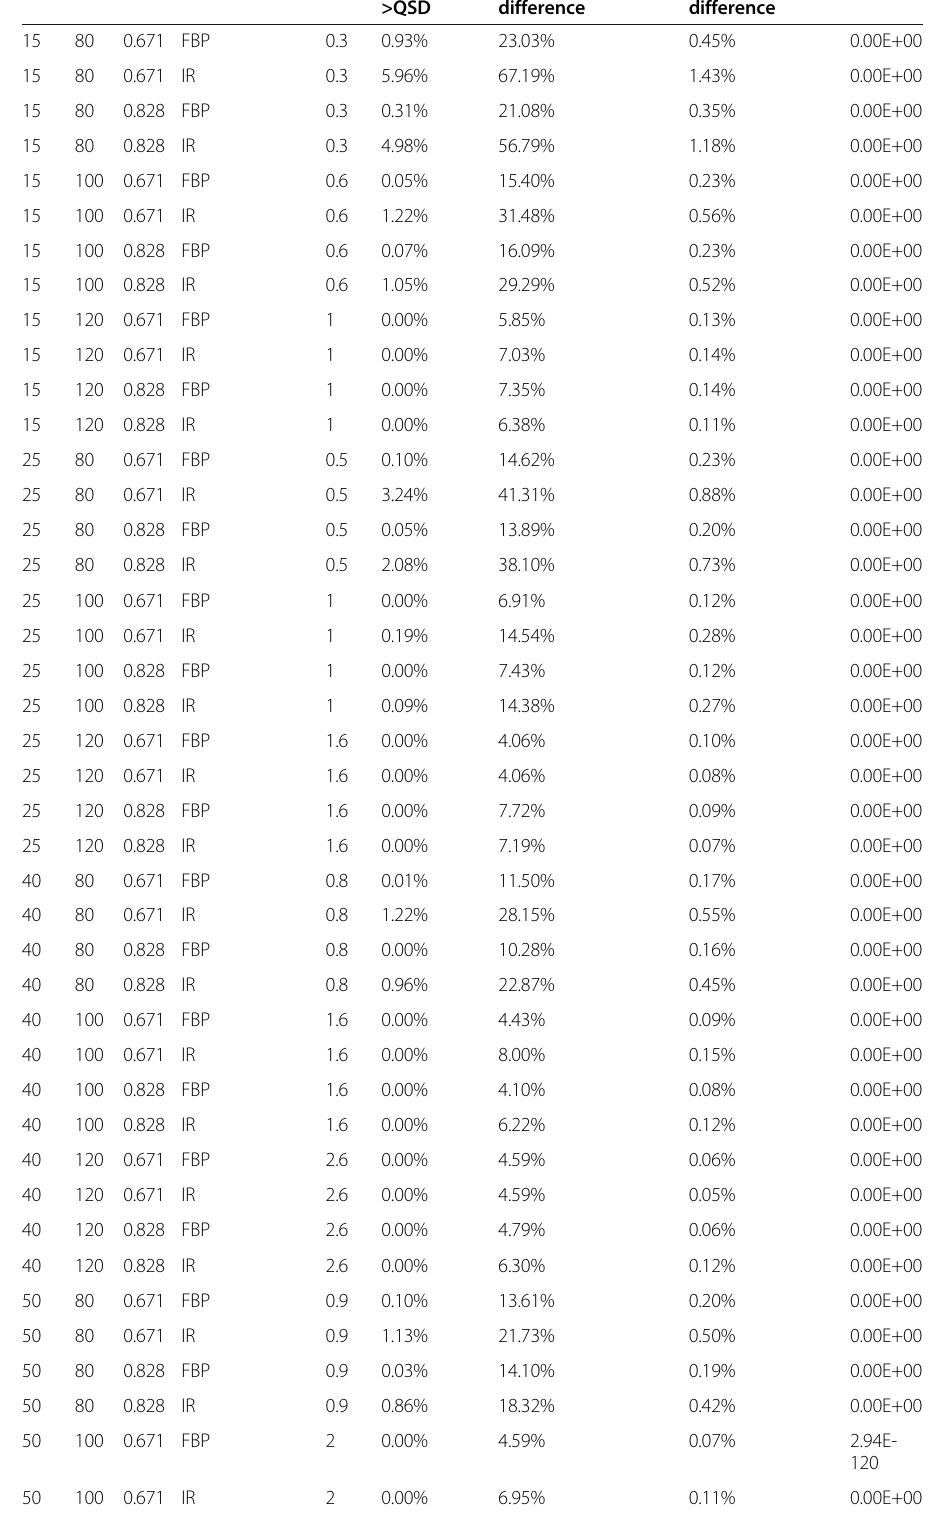
Table 3 Results of voxel-based analysis for each TR compared to the RR ( p values stated as 0 are p values below that calculable by